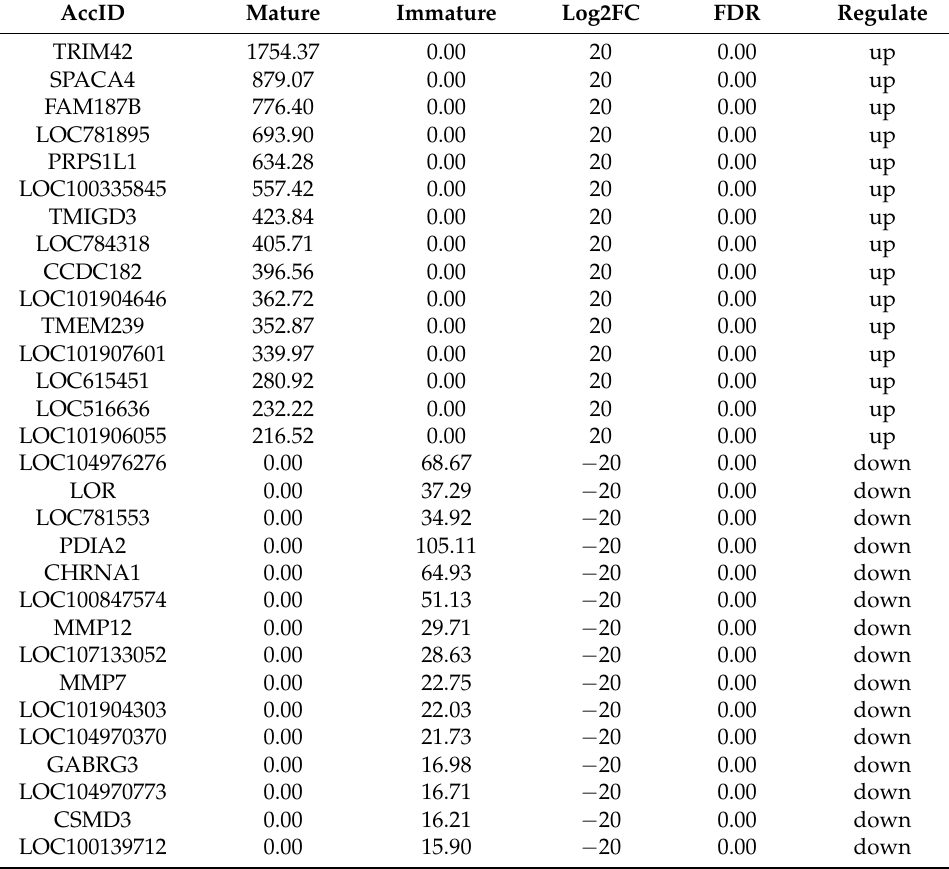
Table 1. The 15 most differentially expressed up- and 15 most differentially expressed down-regulated genes between the immature and mature testicular